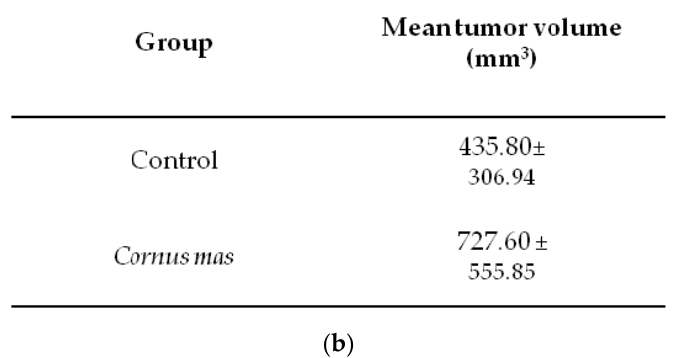
Figure 3. Effect of Cornus mas L. juice to CT26 colon carcinoma. BALB/c mice received Cornus mas L. juice for 10 days per os with oral gavage and were injected subcutaneously with 5 × 10 6 CT26 colon cancer cells. Eight days later, BALB/c mice were euthanized and tumors were harvested; ( a ) table shows tumor volume (mm 3 ) and incidence (%) in BALB/c mice receiving C. mas L. juice (treated group) or phosphate buffered saline (PBS) (control group). Mean tumor volume did not differ significantly between the groups under study ( p = 0.164); ( b ) box-plots display the distribution of tumor volume (mm 3 ) in the control and treated group of BALB/c mice.